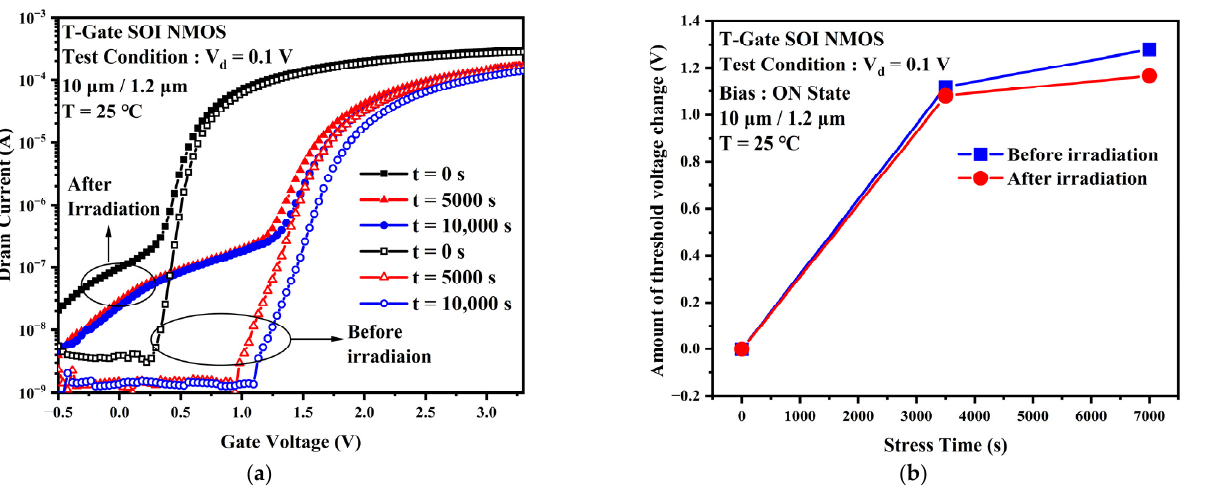
Figure 9. ( a ) Transfer characteristic curves before and after irradiation with TDDB stress applied. ( b ) Amount of threshold voltage changes when TDDB stress is applied before and after irradiation.